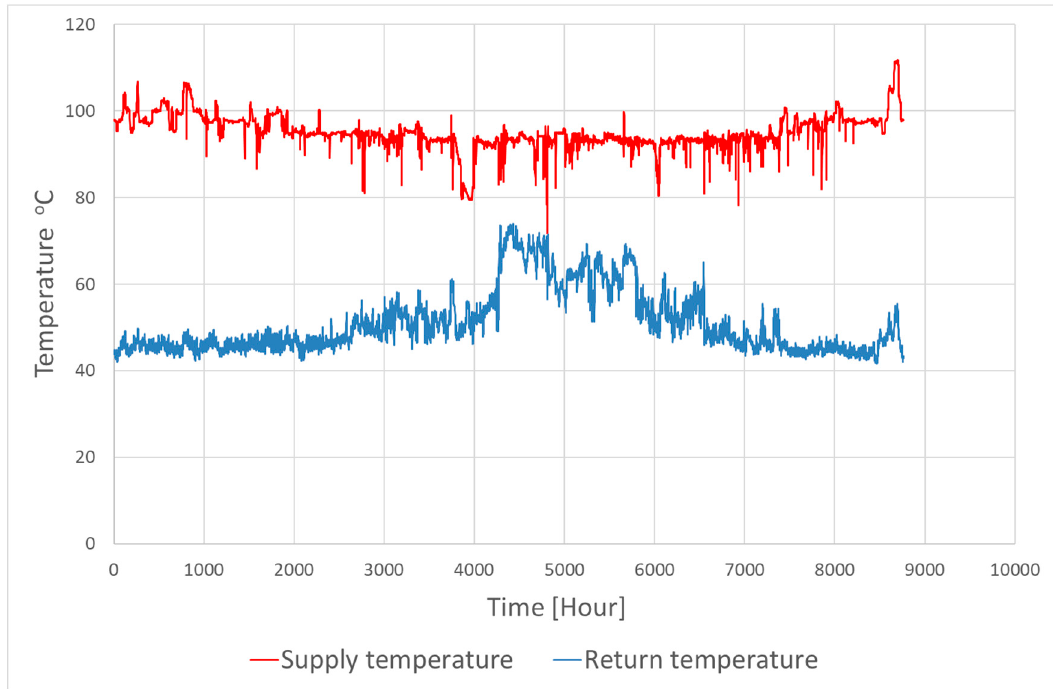
Figure 7. Measured supply and return temperatures in Linköping’s DHS in 2015. Energies 2019 , 12 , x FOR PEER REVIEW